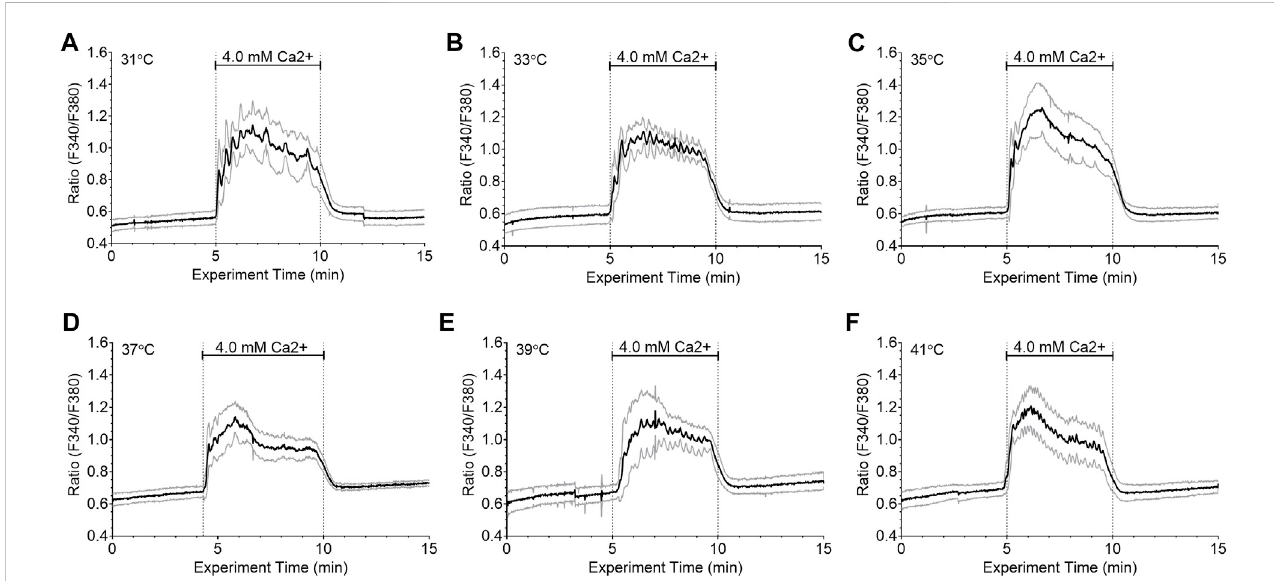
FIGURE 3 Lack of effect of temperature on integrated Ca 2+ i responses in HEK-CaSR cells. HEK-CaSR cells were loaded with fura-2 AM at baseline Ca 2+ o (0.5 mM) and adjusted to various set temperatures in the range 31 ° C – 41 ° C. They were then exposed to elevated Ca 2+ o (4.0 mM) for 5 min prior to return to baseline. Panels (A — F) showtime-coursesforthemeanresponses(solidblacklines)aswellasresponsesformeansplusoneSDandmeansminusoneSD(greylines)for 10 individual cells in each case. Temperature had no effect on the integrated Ca 2+ i responses under the conditions of these